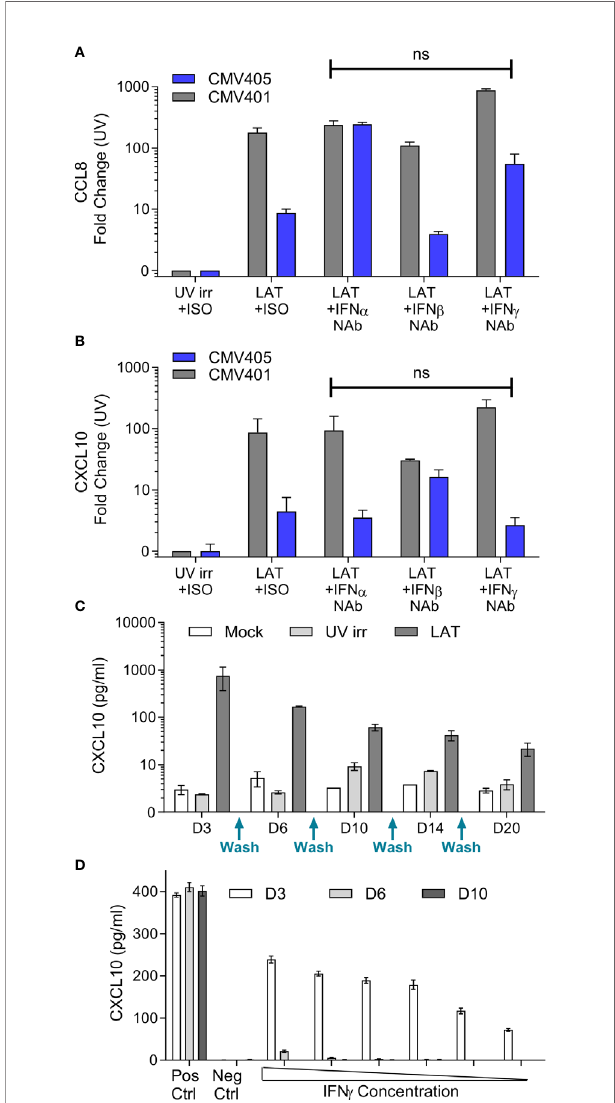
FIGURE 2 | Production of CCL8 and CXCL10 by latently infected CD14+ monocytes is independent of interferon signaling. Neutralization of IFN a , IFN b and IFN g does not prevent the production of either CCL8 (A) or CXCL10 (B) from latent infected CD14+ cells at day 7 post infection. CXCL10 and CCL8 was measured by ELISA, with background chemokine production in response to mock infection subtracted and fold-change results above UV irradiated infection from 2 CMV sero-negative donors CMV401 and CMV405 shown. There was no signi fi cant (ns) change in the production of CCL8 or CXCL10 in the presence of neutralizing antibodies (Kruskall-Wallis test). (C) Freshly isolated monocytes were infected with TB40/E virus as described, cell supernatant was removed and replaced (indicated on x-axis) over a 20- day period, error bars represent SEM. This shows that CXCL10 is only reproduced by the latent infected monocytes over this time period. (D) Treatment of monocytes by recombinant IFN g protein shows CXCL10 is detectable at day 3 but lost at later time points. Freshly isolated monocytes were stimulated with decreasing amount of IFN g from 100IU/ml for 4 hours. Supernatants were collected on days 3 (white), 6 (grey) and 10 (black). Levels of CXCL10 were assayed using ELISA. Positive control consisted of continuous 100IU/ml IFN g and negative control was media alone. This is the representative results of three repeats, error bars represent